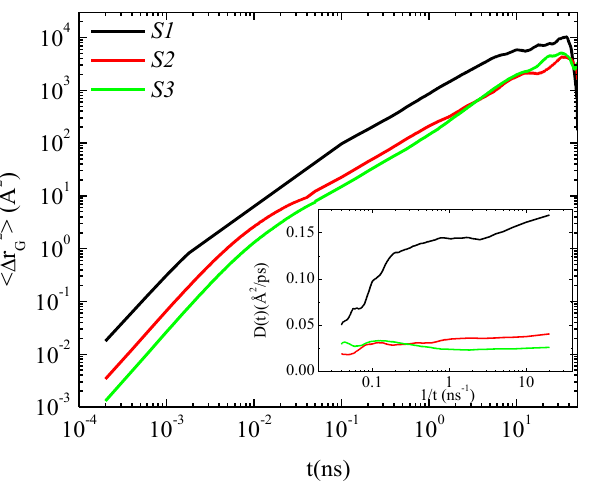
Figure 12. Mean squared displacement as function of time for the center of mass of the graphene sheet for the S1, S3 and S3 systems. Inset graph: Effective time dependent diffusion coefficient of graphene sheets as a function of inverse time for the three